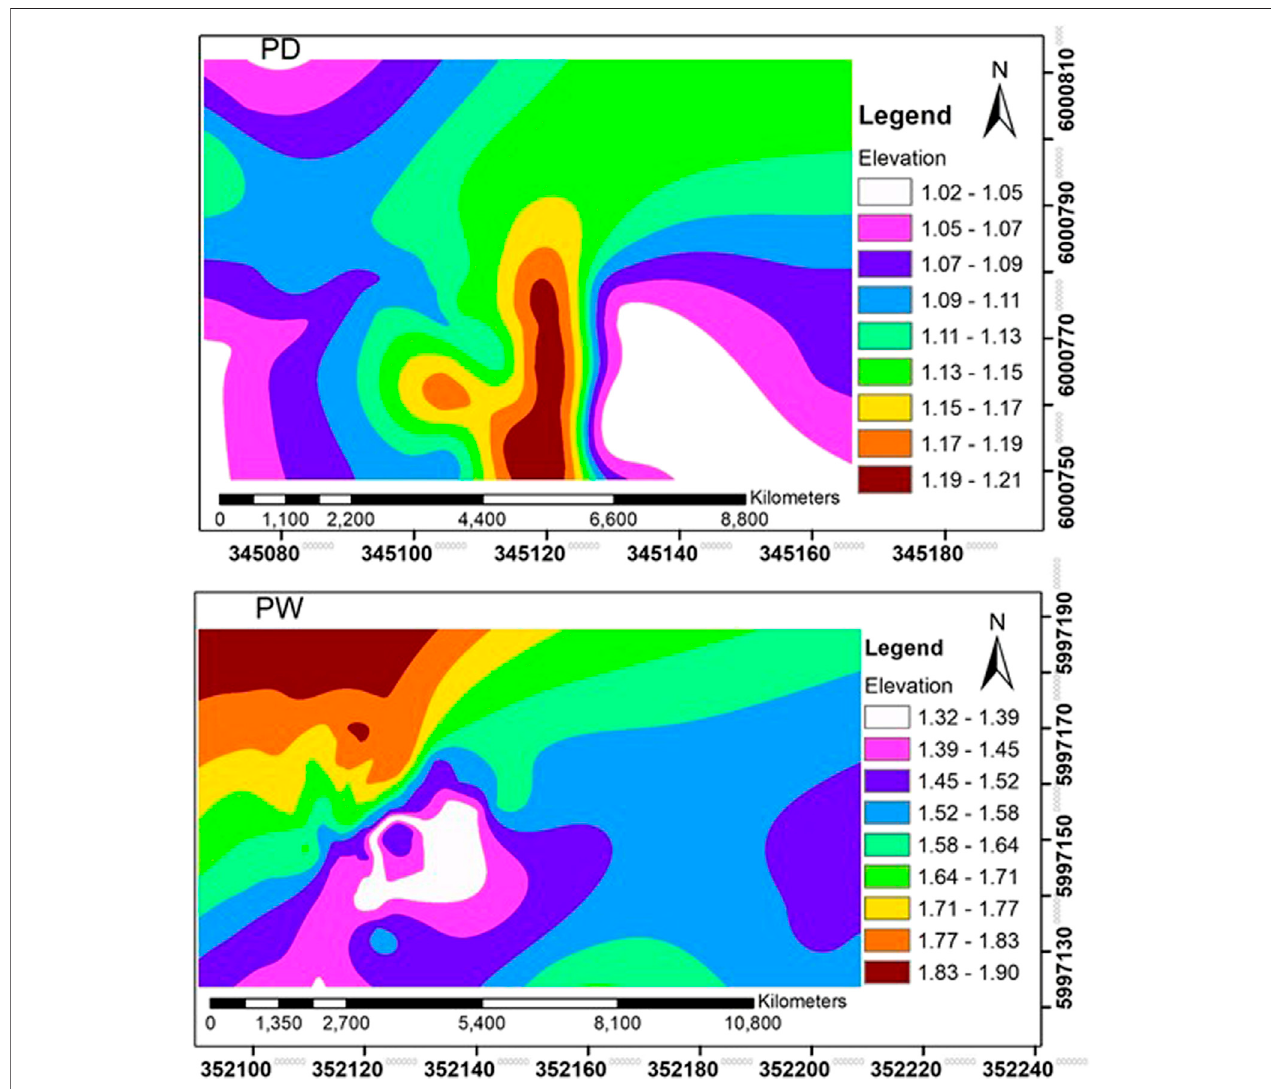
FIGURE 2 | Spatial patterns of elevations of the drained (PD) and rewetted (PW) peatlands of the soil sampling points elevation: m.